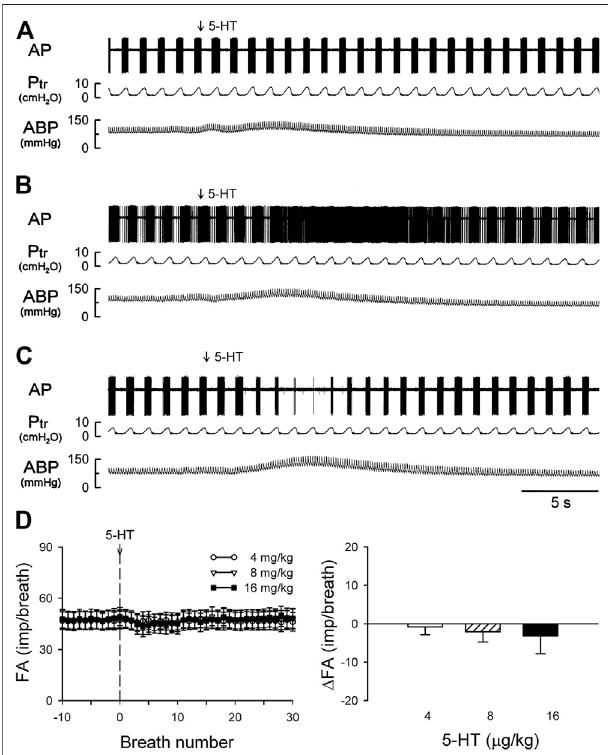
FIGURE 6 | (A – C) experimentalrecordsillustratingthreedifferenttypesof SAR responses to i. v. injections of 5-HT (16 μ g/kg) in three anesthetized, vagotomized,open-chest,andmechanicallyventilatedrats: (A) noeffectof5-HT (405 g; receptor in right lower lobe); (B) delayed stimulation (400 g; right middle lobe); (C) delayed inhibition (395 g; right lower lobe). (D) Average responsesoftheentiregroupofSARs(n=17)toi.v.bolusinjectionofincreasing doses of 5-HT (depicted by the vertical dashed line), separated by a 15-min interval between two injections. FA: fi ber activity; Δ FA was calculated as the difference between the baseline FA (20-breath average) and the peak FA (average of 5 consecutive breaths). Data are means ± SEM.